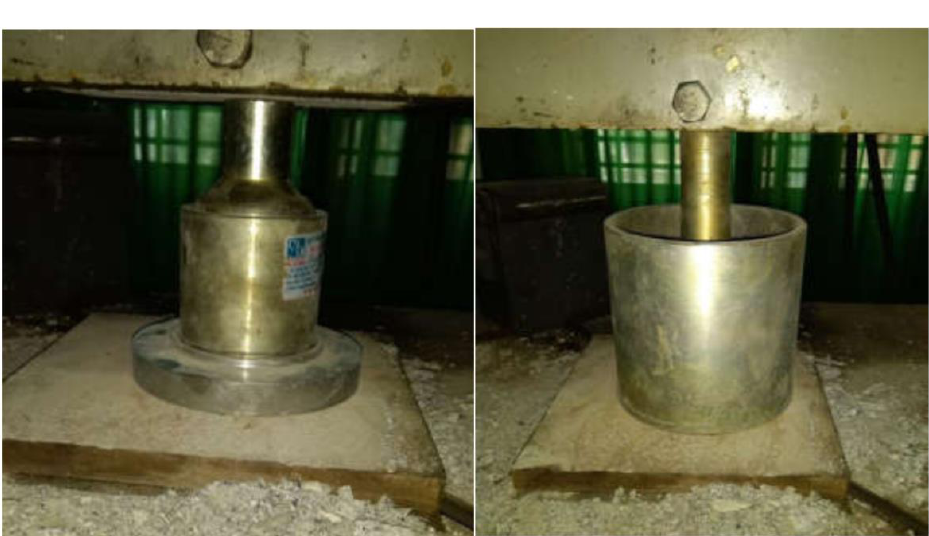
Figure 4. Test for aggregate crushing value.